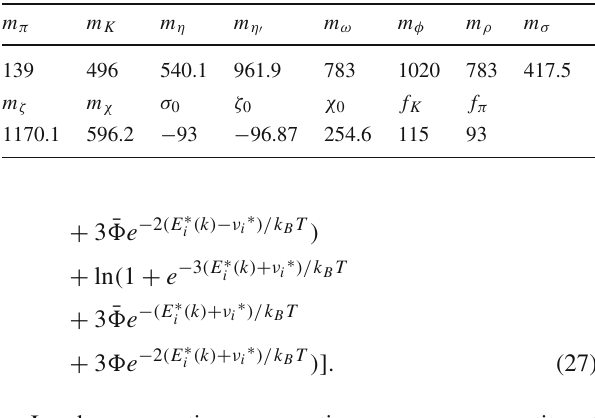
Table 1 Parameters for Polyakov effective potential Table 3 Values of different meson masses and decay constants (in MeV)